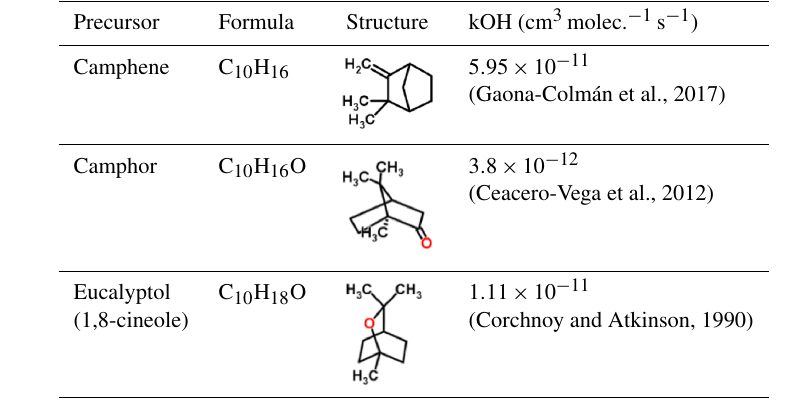
Table 1. Volatile organic compounds investigated in this